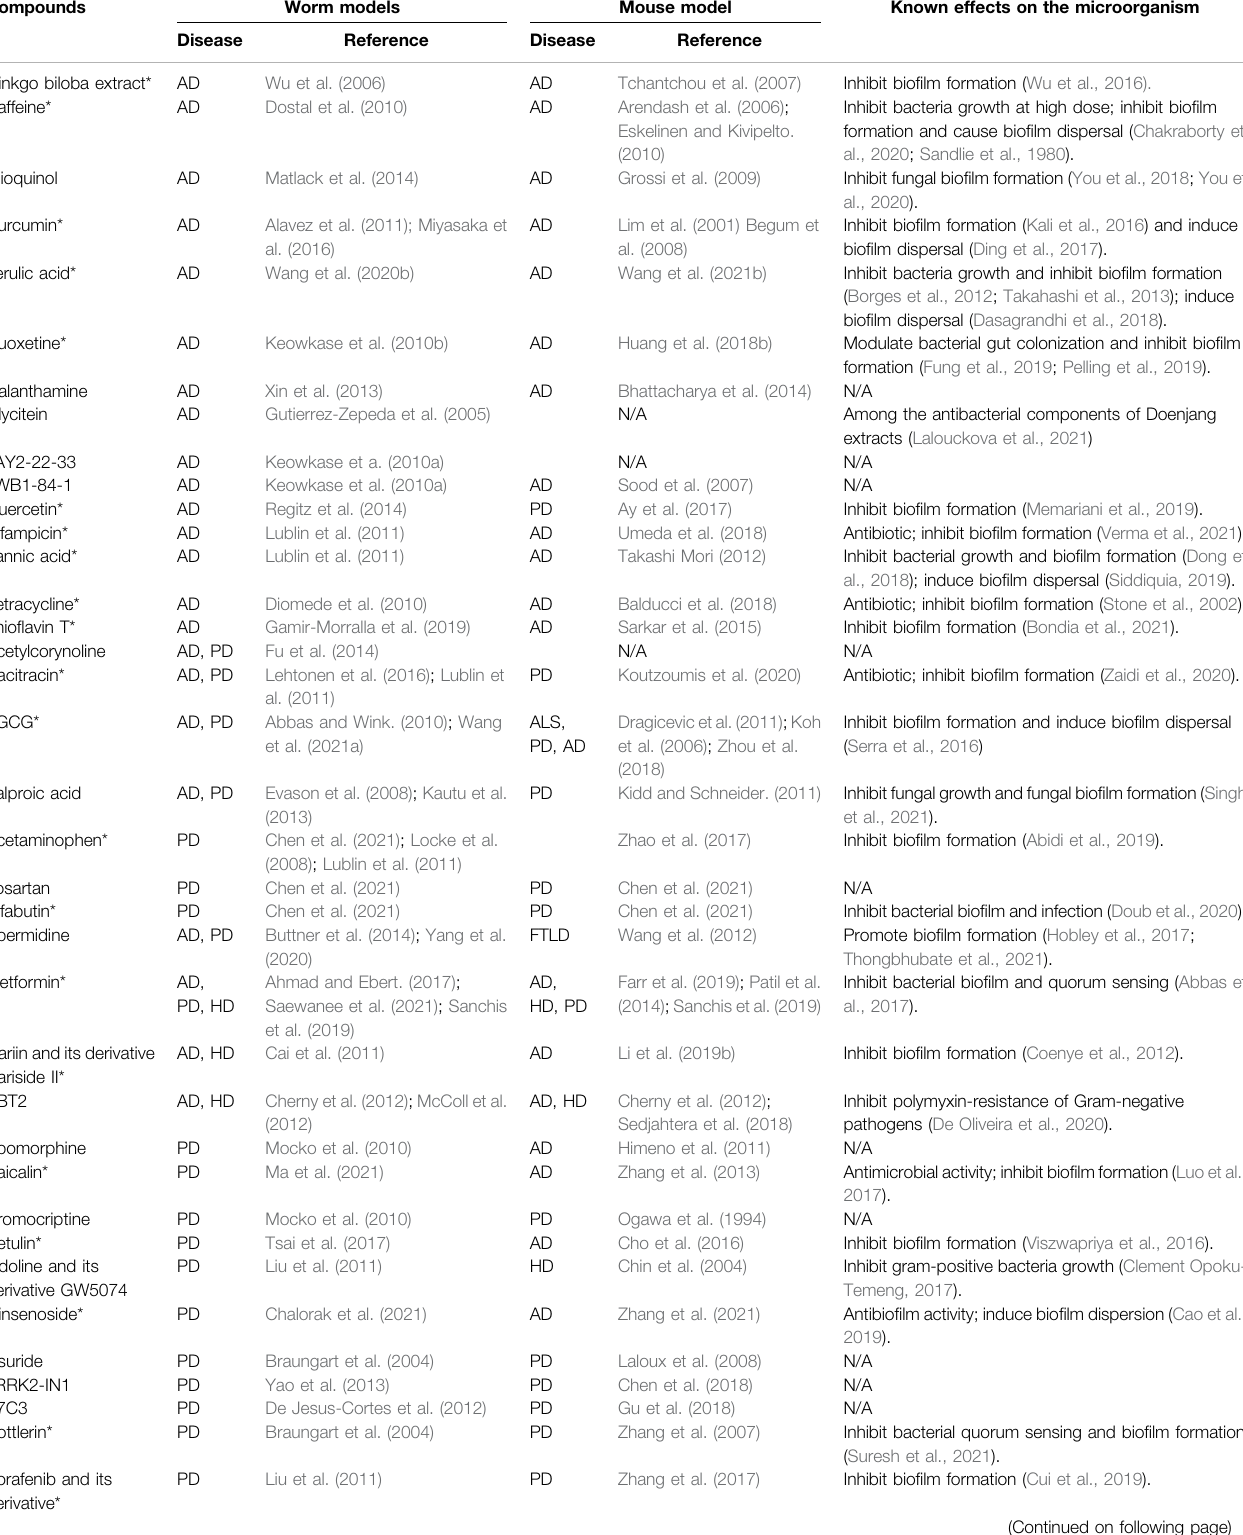
TABLE 1 | Neuroprotective compounds identi fi ed in C. elegans neurodegenerative disease models and con fi rmed in mouse models showed effects on